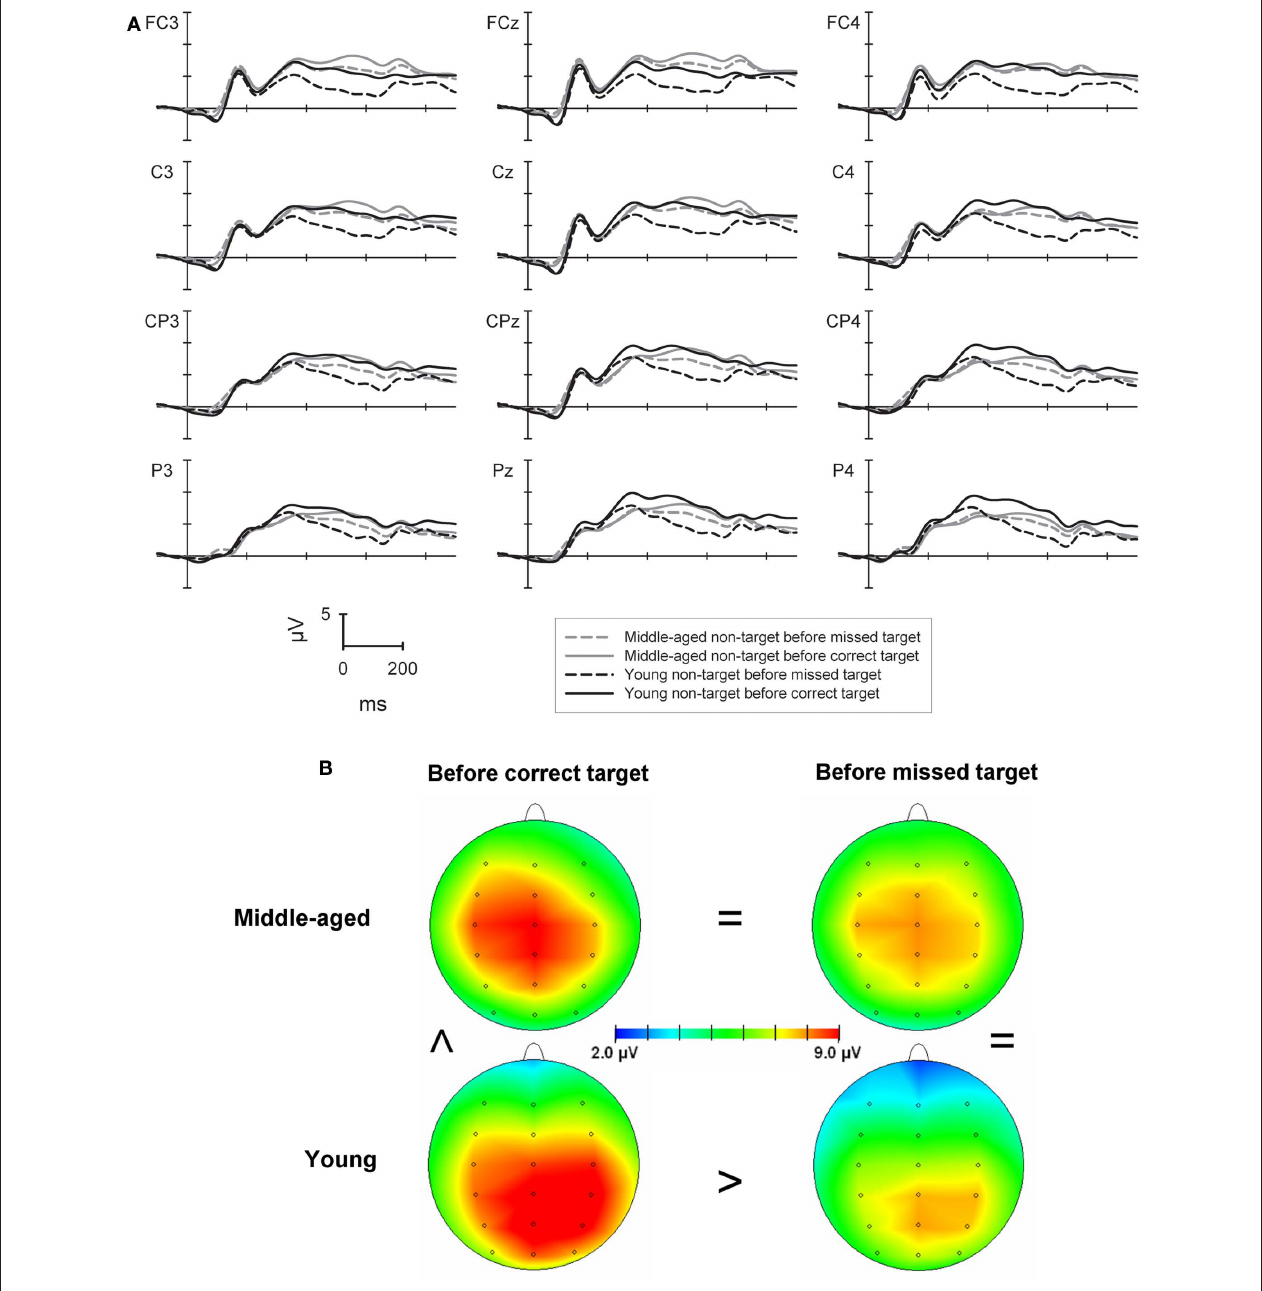
Figure 3 | (a) P300 in the 2-back task at selected electrodes for the middle-aged (gray lines) and young group (black lines) to correctly classified non-target stimuli which directly preceded correctly detected (solid lines) or missed targets (dashed lines) in the following trial. (b) Shows the maps of the